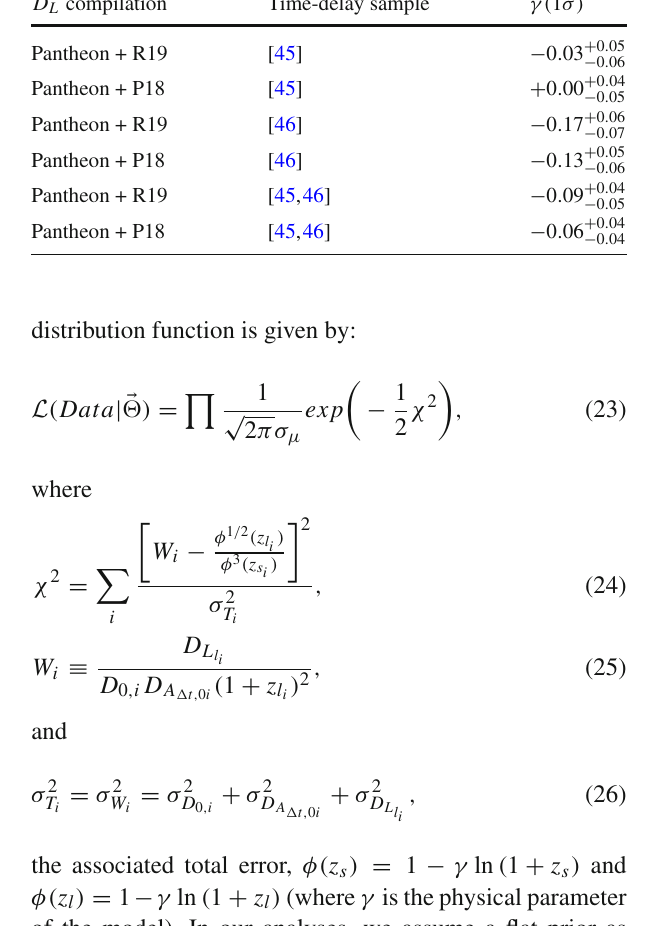
Fig. 4 The red and blue contours represent the posterior probability distribution functions for 19 time-delay Systems from [45,46], but with distinct D L measurementsfrom Pantheoncompilationby[62](red)and [63] (blue). The vertical green dashed line is the limit γ = 0, and the horizontal grey dashed lines represent 1 σ and 2 σ confidence levels Table 1 Constraints on a possible time variation of the fine-structure constant for the parameter γ of the runaway dilaton model in 1 σ of confidence level D L